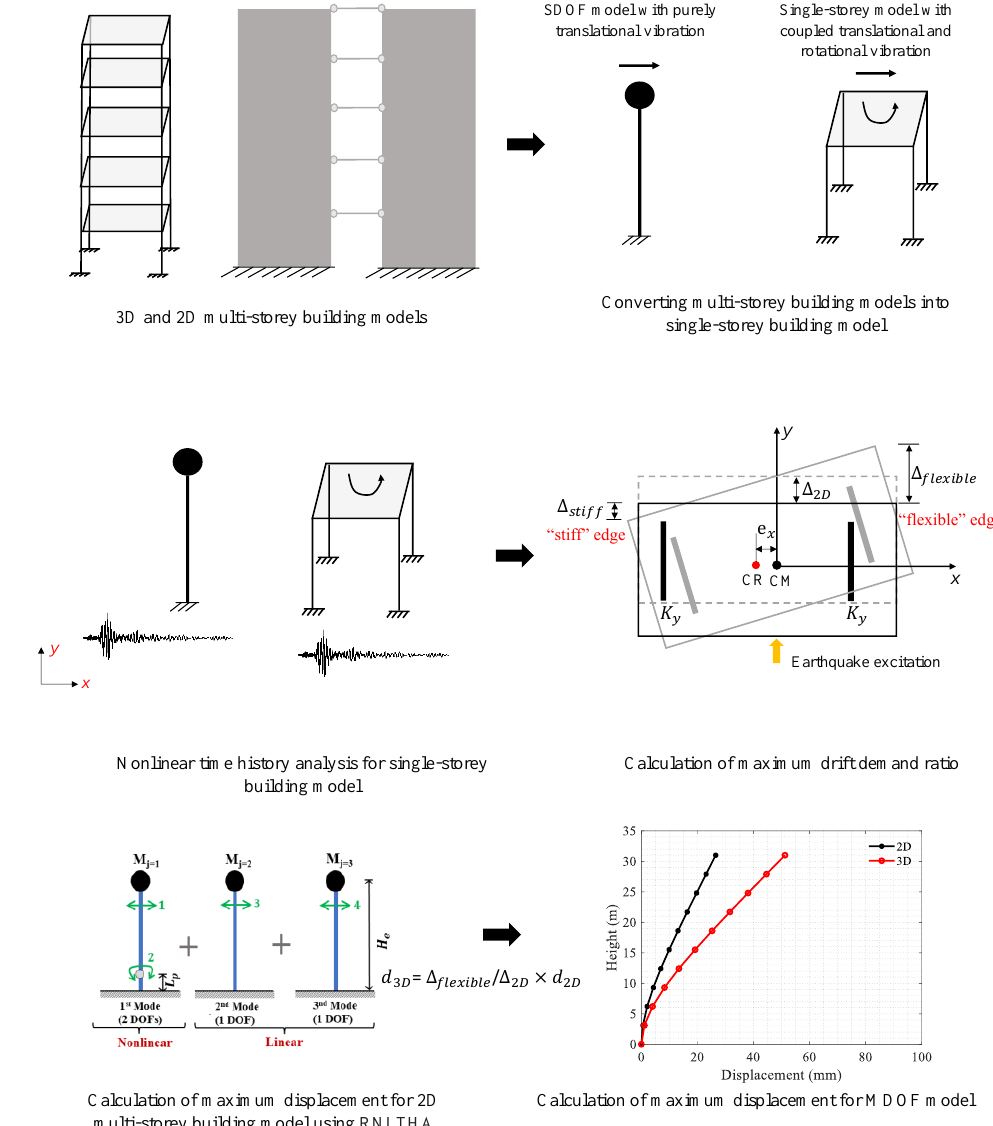
Figure 4. The procedure of obtaining the ∆ 3D / ∆ 2D drift demand ratio vs. nonlinear displacement using rapid nonlinear time history